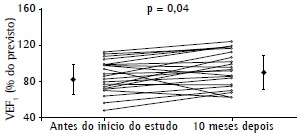
VEF1 (% do previsto) antes do início do estudo e 10 meses depois.
Nota-se que o VEF1 estava significativamente maior 10 meses depois. Os
losangos representam média ± dp.